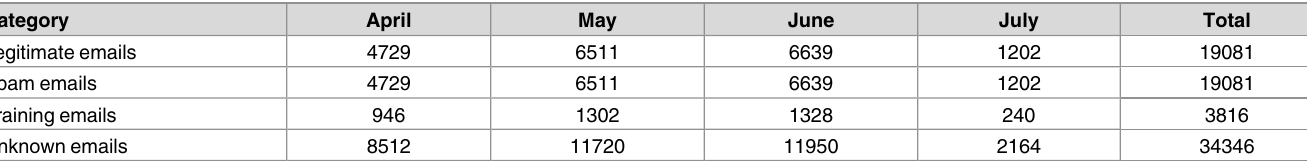
Table 3. The email numbers of the four months.